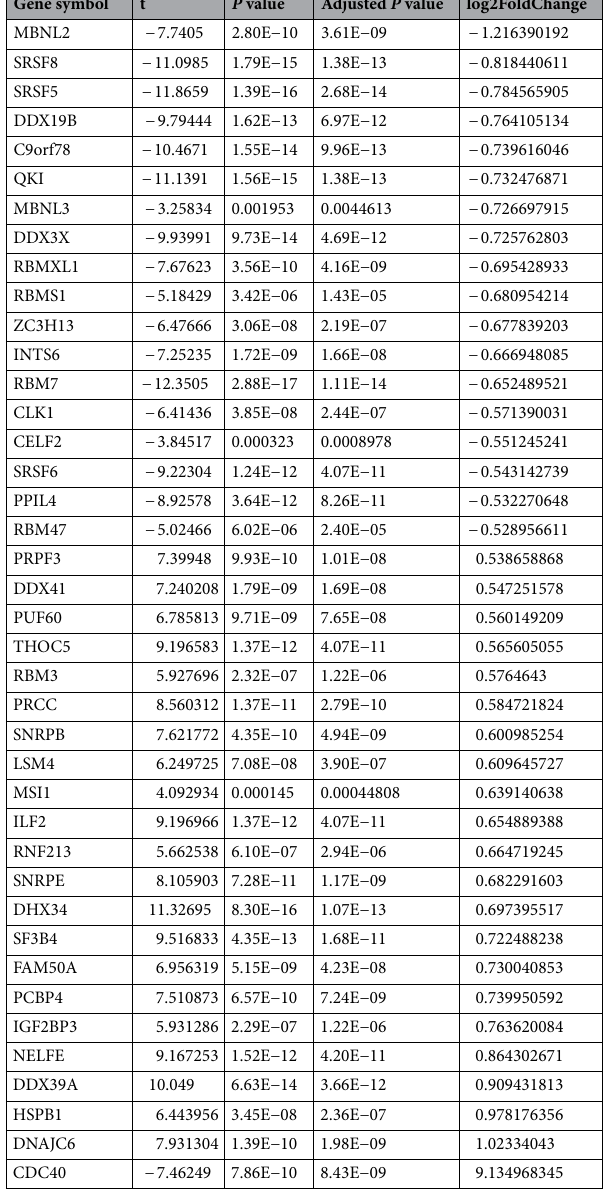
Table 1. The dysregulated SFs in HCC tumor tissues compared with adjacent normal tissues. SFs splicing factors, HCC hepatocellular